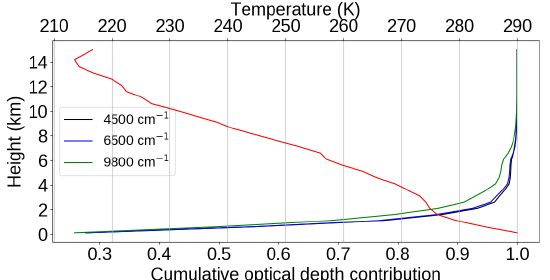
Figure 12. Fractional contribution to the total continuum optical depth (using MT_CKD_3.2) with height from the surface up to 10km at three wavenumbers. The temperature profile (top axis) de- rived from radiosonde on 18 September 2008 is shown in